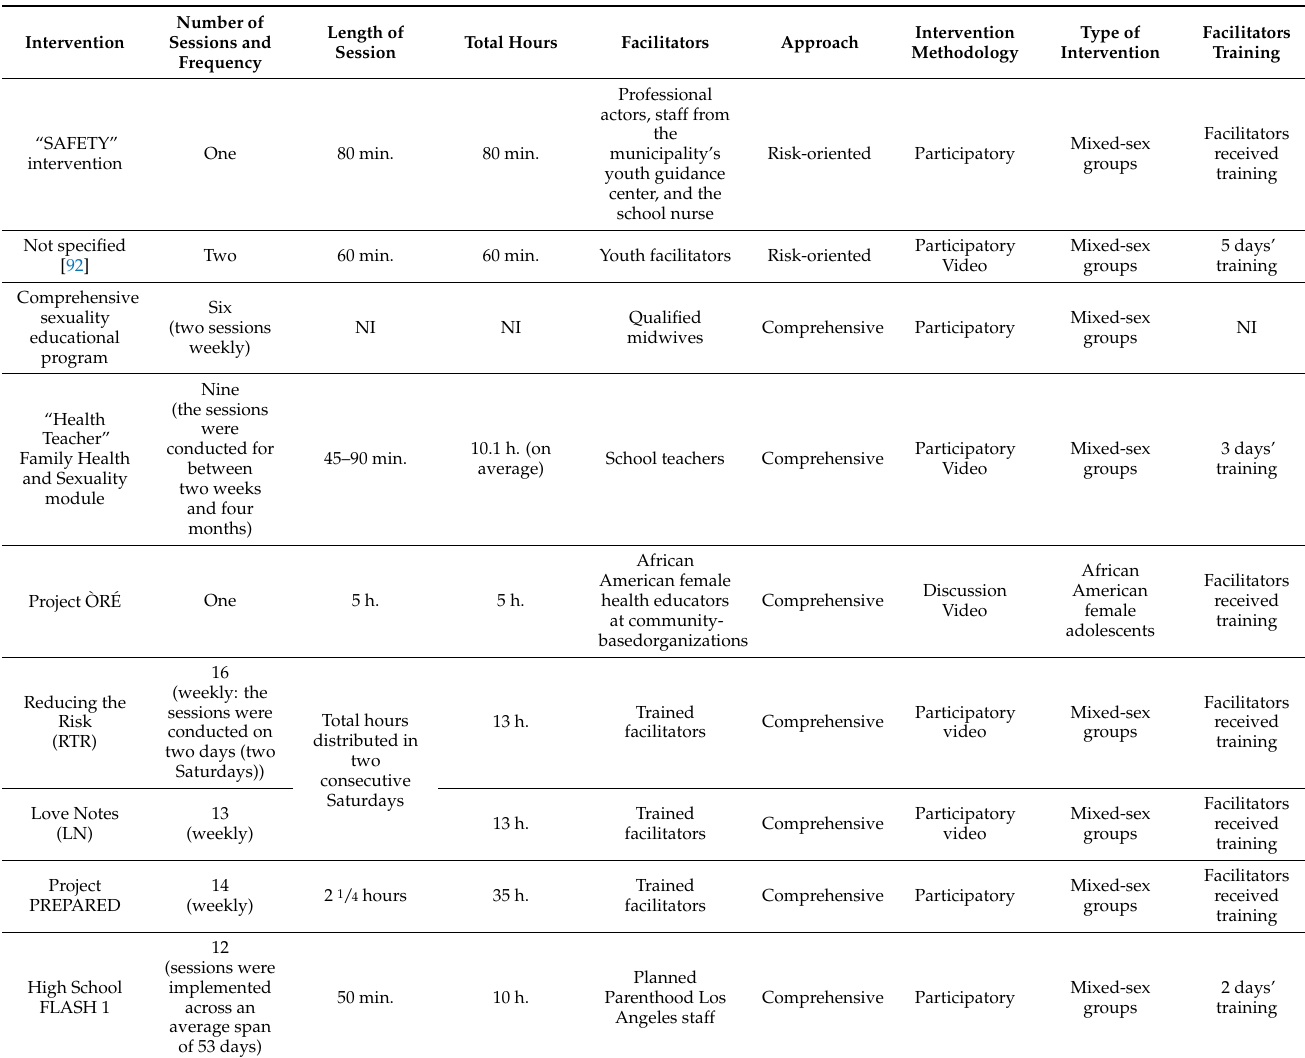
Table 3. Sexuality education interventions’